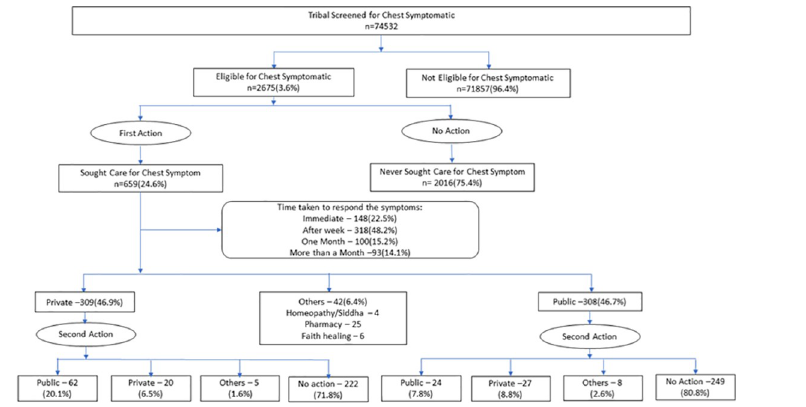
Fig 1. Care seeking behaviour of chest symptomatic.